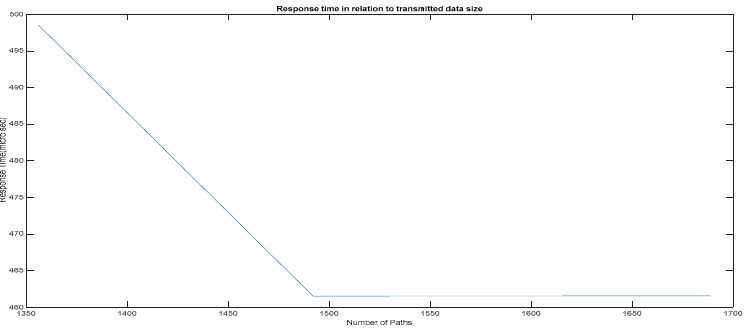
Figure 12. A comparison of response time and the number of possible routes.